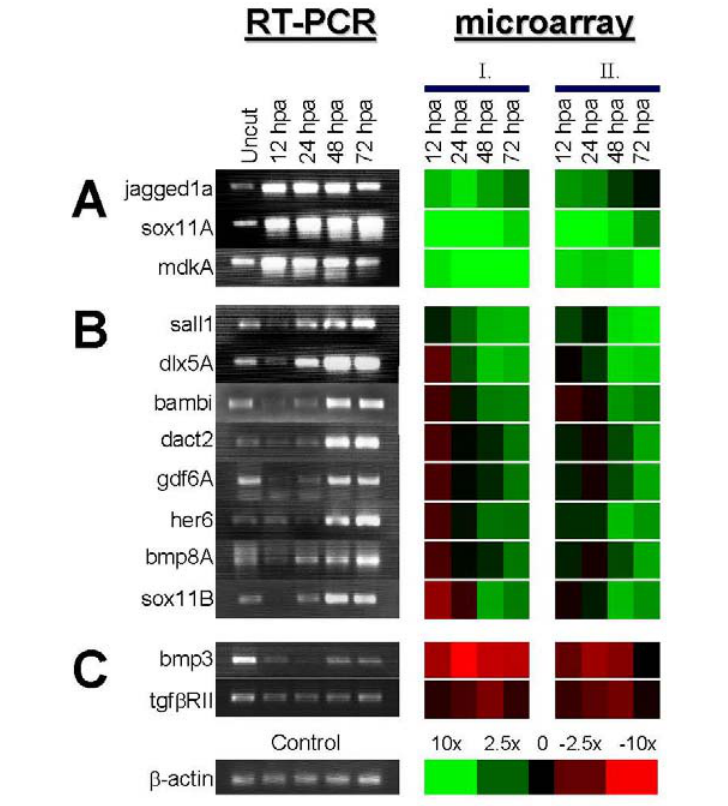
FIGURE 3 . Verification of microarray results by RT-PCR. Semi- quantitative RT-PCR was performed on selected genes using uninjured or regenerating fin-tissue isolated at 12, 24, 48, and 72 hpa as template. Genes were grouped for early up-regulation (A), late up-regulation (B), or down-regulation (C). Note that RT-PCR results (left panel) correlate well with microarray results (right